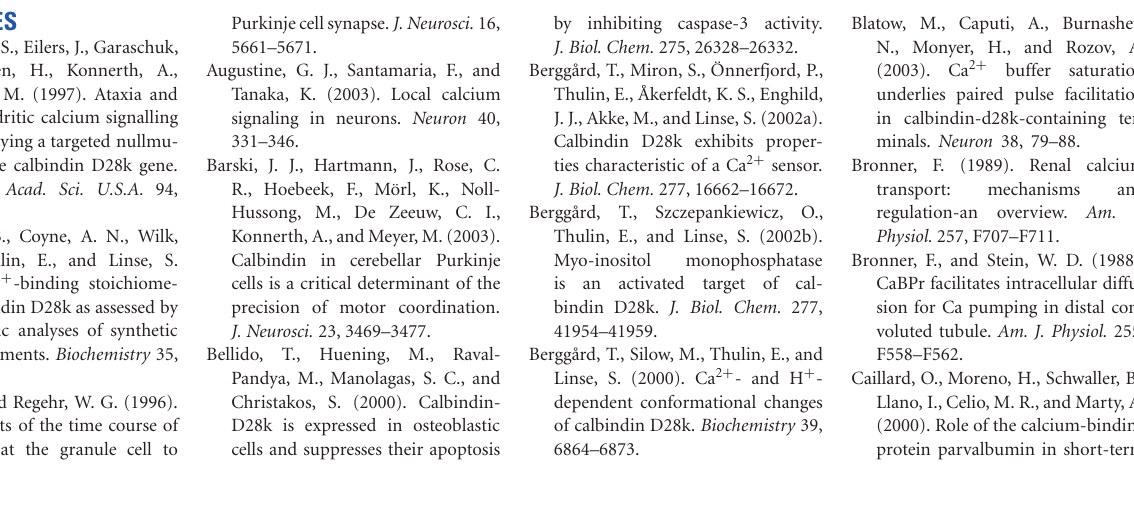
( Table 1 ). In vitro , apo- and Ca 2 + -bound CB activated IMPase similarity up to 250-fold. The activation was most